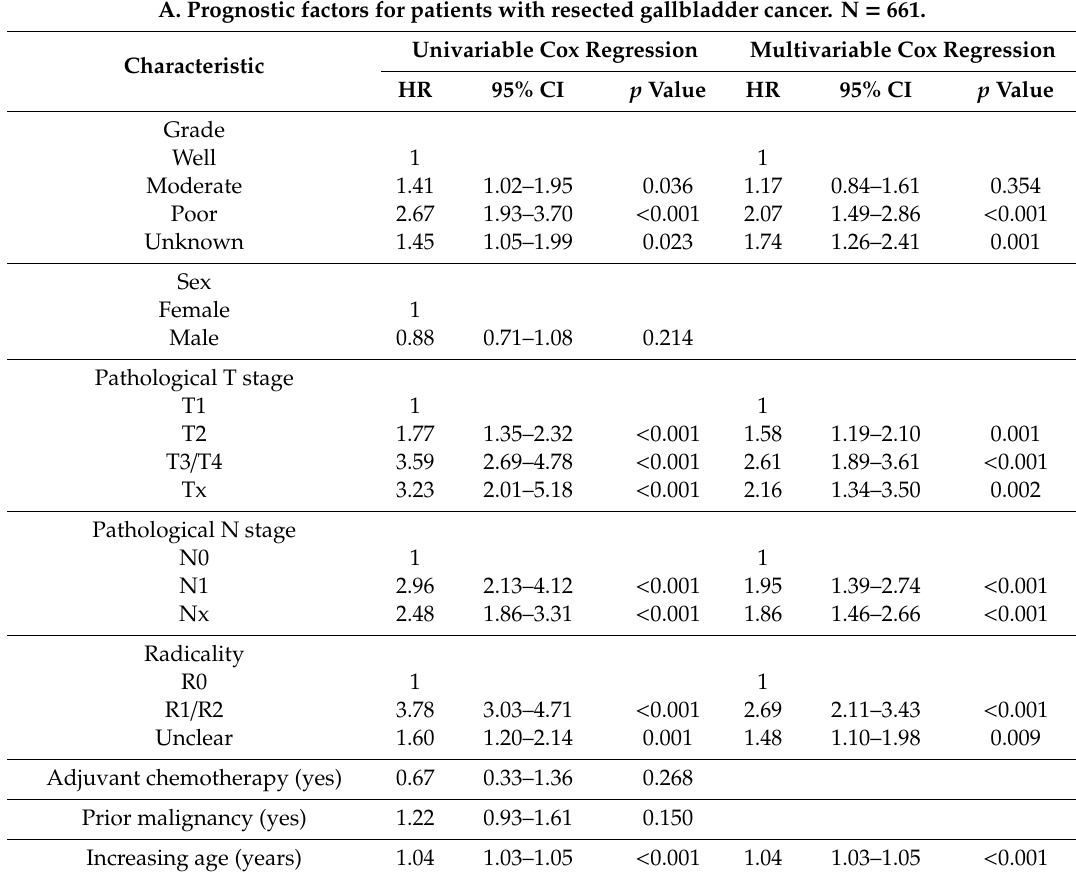
Table 3. Prognostic factors for patients with resected ( A ) and metastatic ( B ) gallbladder cancer. A. Prognostic factors for patients with resected gallbladder cancer. N =